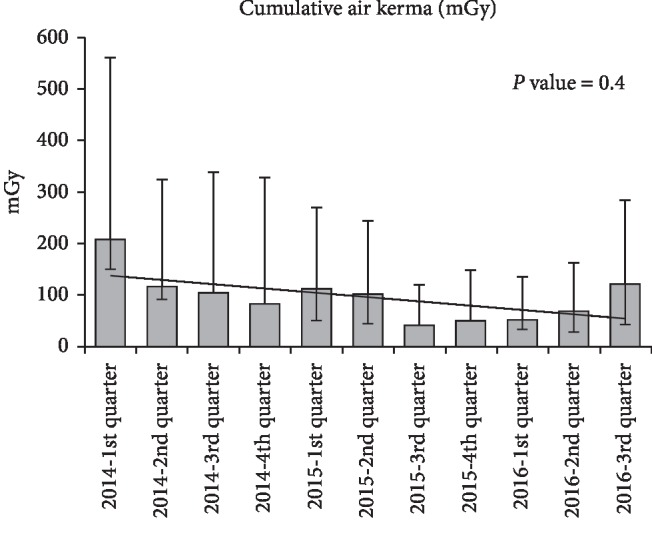
Quarterly cumulative Air Kerma trend across centers (adjusted by center, age, and weight). P value = 0.4.